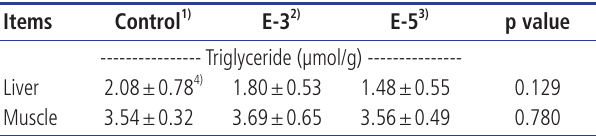
Table 5. Effects of feeding ethanol on triglyceride contents of liver and sternocephalicus muscle of finishing Korean cattle (Hanwoo) steers